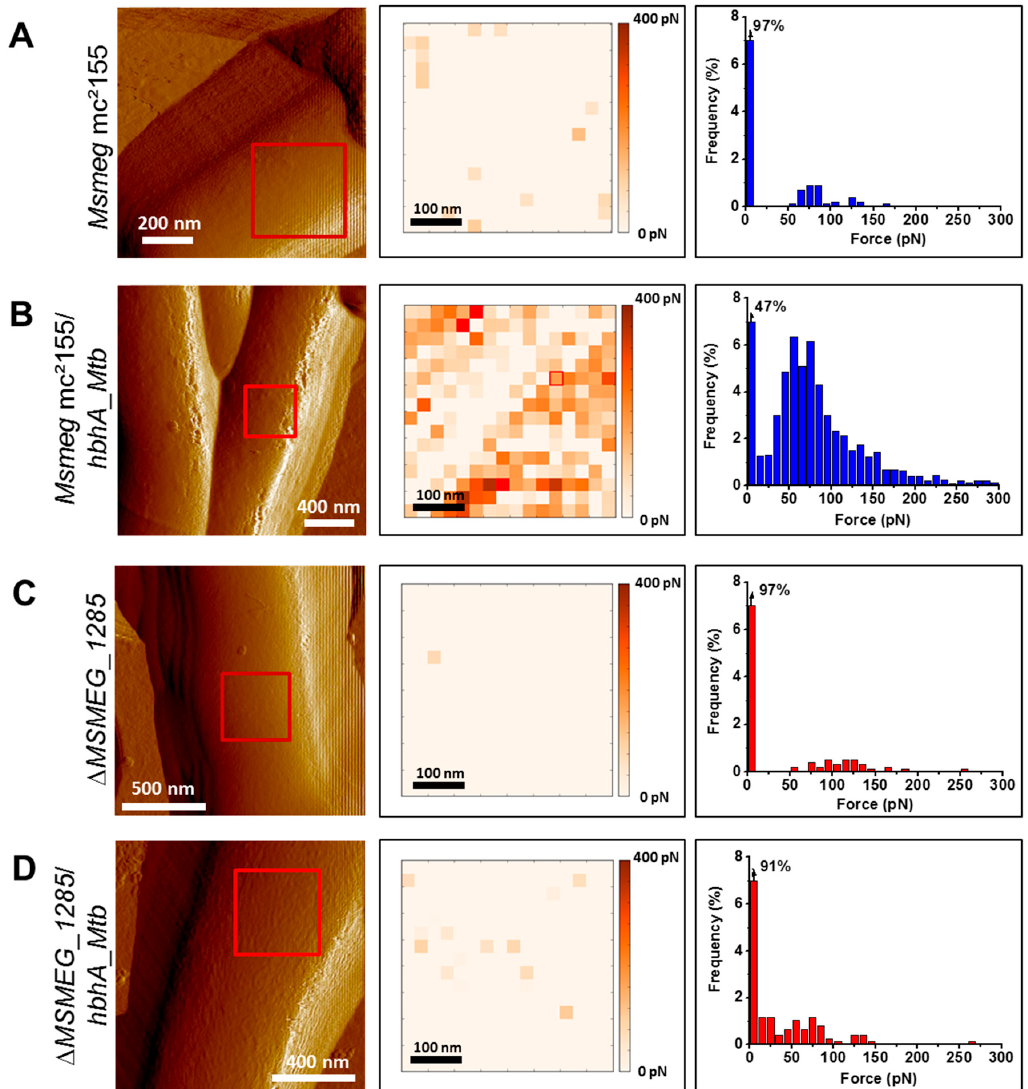
Figure 3. Deletion of MSMEG_1285 in Msmeg mc 2 155 impacts the cell-surface exposure of HBHA_ Mtb . AFM tomographic image (left panel), representative spatially-resolved map of adhesion forces recorded with AFM heparin-coated tip (medium panel) and corresponding histogram (right panel, obtained from 756 force curves) for ( A ) the wild-type strain of Msmeg , ( B ) Msmeg mc 2 155 expressing hbhA_Mtb , ( C ) the Δ MSMEG_1285 mutant and ( D ) the Δ MSMEG_1285 mutant expressing hbhA_Mtb . All the strains were cultured in 7H9 supplemented with OADC and without detergent. For each image, the red square corresponds to the area scanned for the determination of one adhesion map.